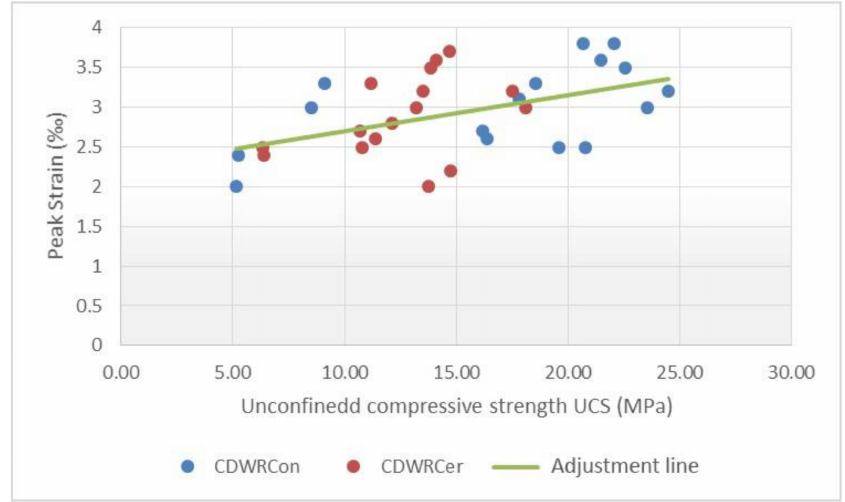
Figure 14. Relationship between unconfined compressive strength and peak strain.